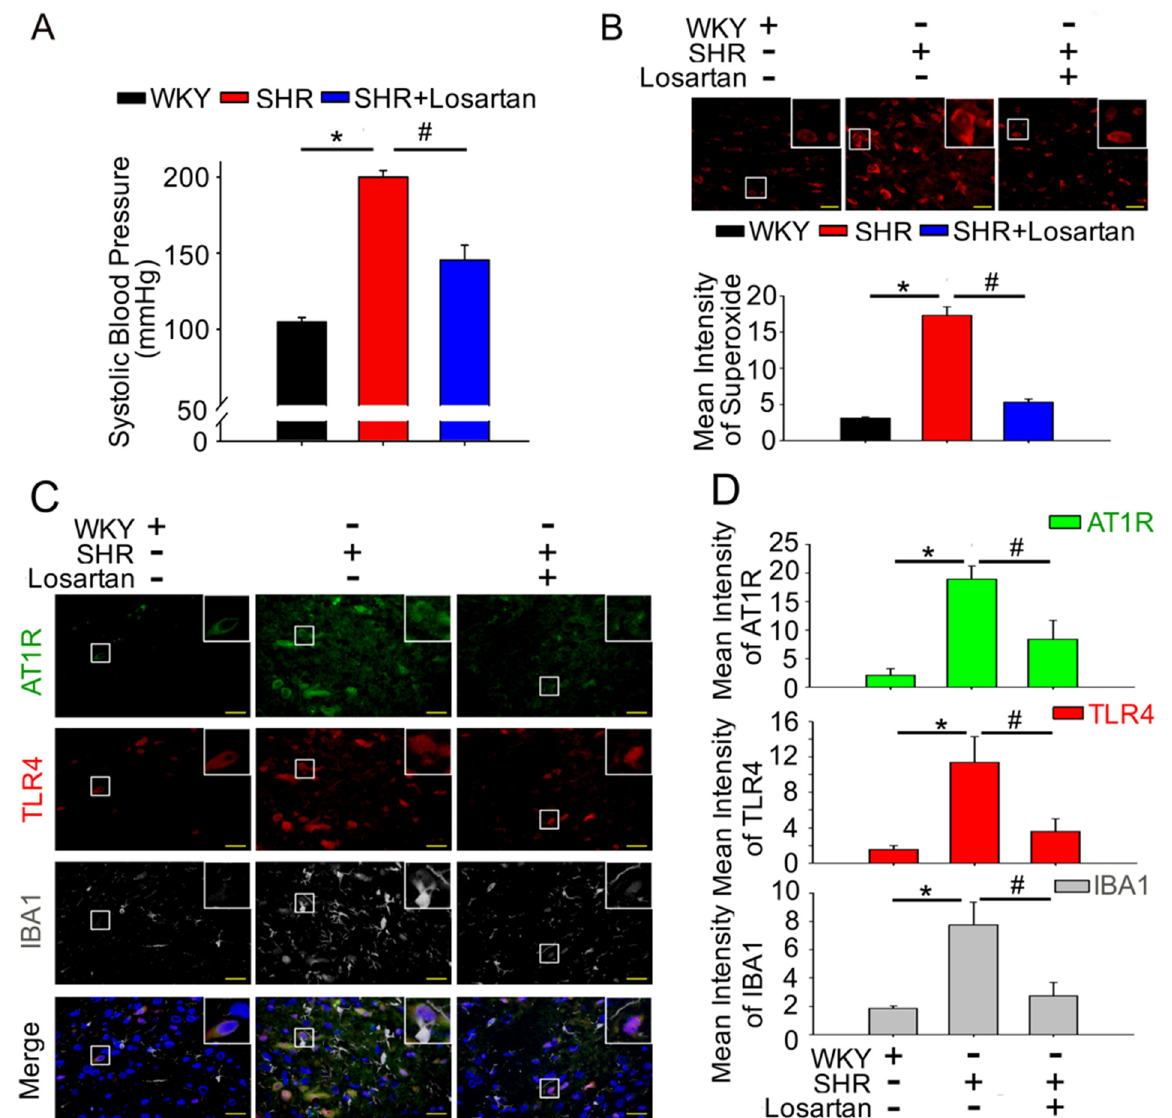
Figure 2. The downregulation of AT1R-induced superoxide generation is associated with the activation of microglia and the expression of TLR4 in the NTS of spontaneously hypertensive rats. ( A ) SBP after losartan administration for 2 weeks. ( B ) Representative images of DHE-treated brain sections, photographed at ×280 magnification. Bar graph representation of ROS index in the NTS of WKY, SHRs, and SHRs treated with losartan. ( C , D ) Representative fluorescence images for AT1R (green), TLR4 (red) and microglial marker IBA-1 (white)-positive cells in the NTS sections of WKY, SHRs, and SHRs treated with losartan. The images were photographed at ×400 and 1000 magnification. The Mann–Whitney U-test was performed for statistical analysis in Figure 1E. One-way analysis of variance (ANOVA) with Scheffé post-hoc was per- formed for statistical analysis. The values are presented as mean ± SEM. * p < 0.05 indicates significant difference from 20- week-old WKY. # p <0.05 versus SHR. All data are presented as means ± SEM ( n = 6 per group).